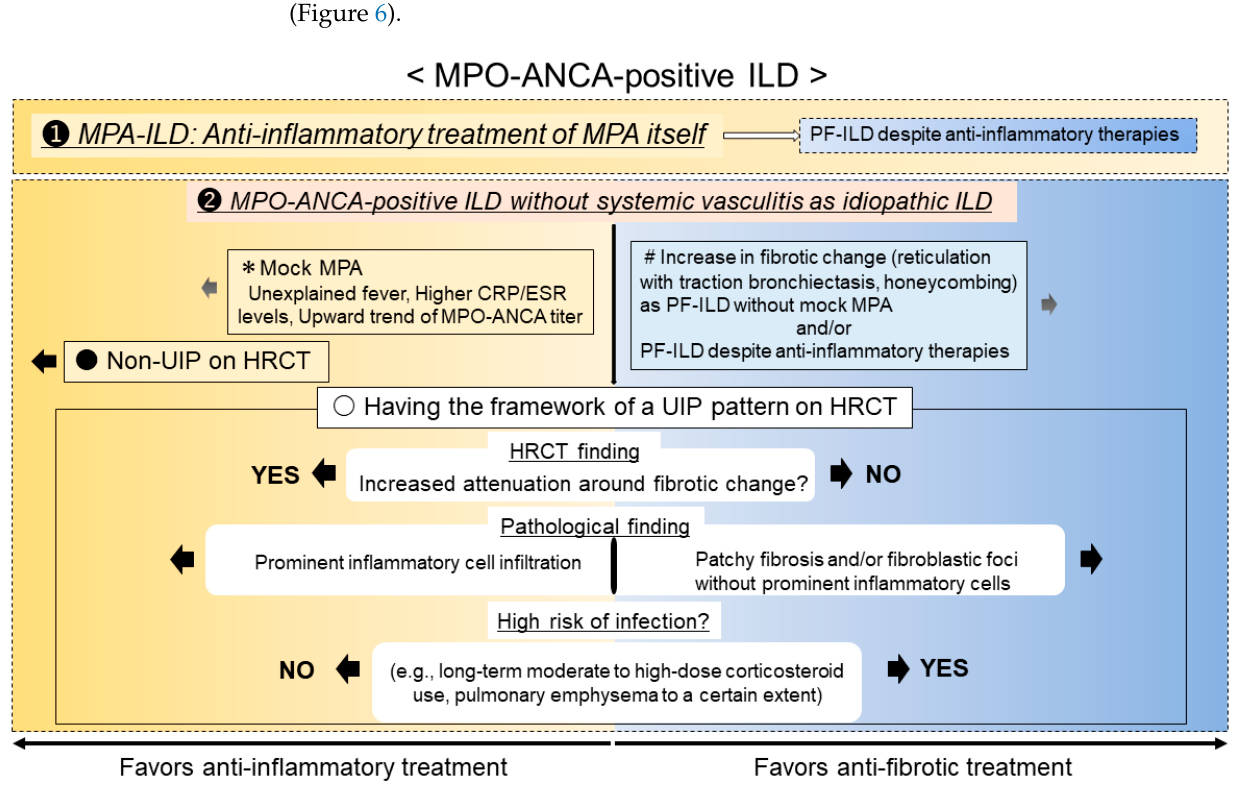
Figure 6. Proposed protocol for the treatment of MPO-ANCA-positive ILD. MPA, microscopic polyangiitis; MPO-ANCA, myeloperoxidase antineutrophil cytoplasmic antibody; ILD, interstitial lung disease; CRP, C-reactive protein; ESR, erythrocyte sedimentation rate; PF-ILD, progressive fibrosing ILD; HRCT, high-resolution computed tomography; UIP, usual interstitial pneumonia.